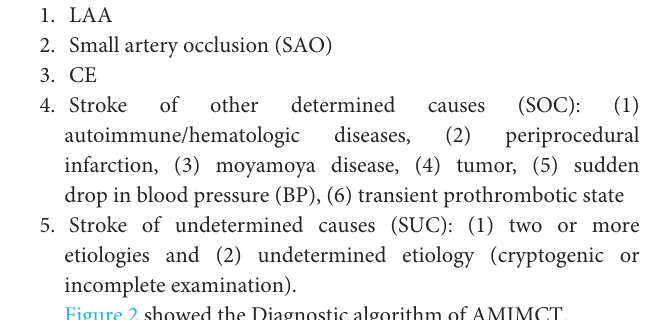
Figure 2 showed the Diagnostic algorithm of